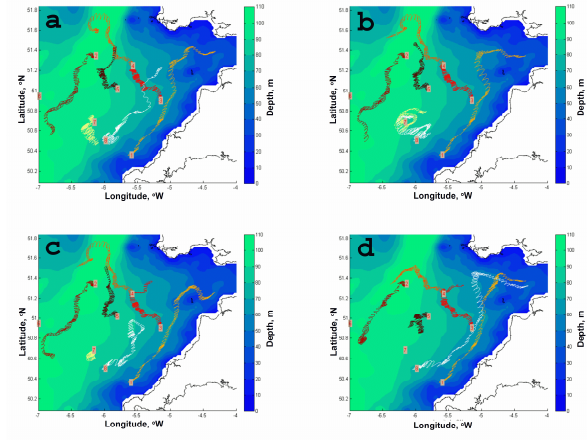
Fig.6. Spatial distribution of kinetic energy per unit area (J/m 2 ) integrated over depth 654 Fig. 6. Spatial distribution of kinetic energy per unit area (Jm − 2 ) from bottom to the surface and averaged over 50 hours. Time averaging is centred 655 integrated over depth from bottom to the surface and averaged over around the spring high water corresponding to the 2nd spring period in Fig.3.The 656 50h. Time averaging is centred around the spring high water cor- charts represent 4 cases: (a)- the baseline case (no energy extraction) (b)- low, (c) 657 responding to the 2nd spring period in Fig. 3. The charts represent medium, and (d) high rated power capacity farm. 658 4 cases: (a) the baseline case (no energy extraction) (b) low, (c) medium, and (d) high rated power capacity farm.